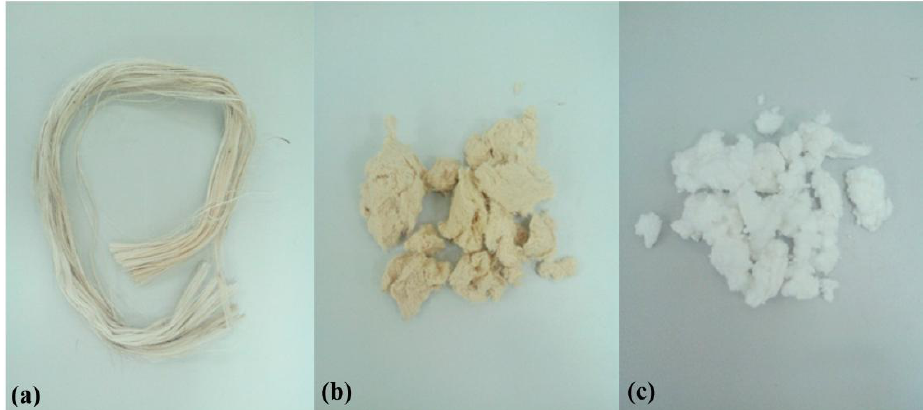
Figure 2. Photographs of ( a ) kenaf fiber; ( b ) fiber after alkali treatment; and ( c ) lignin-free